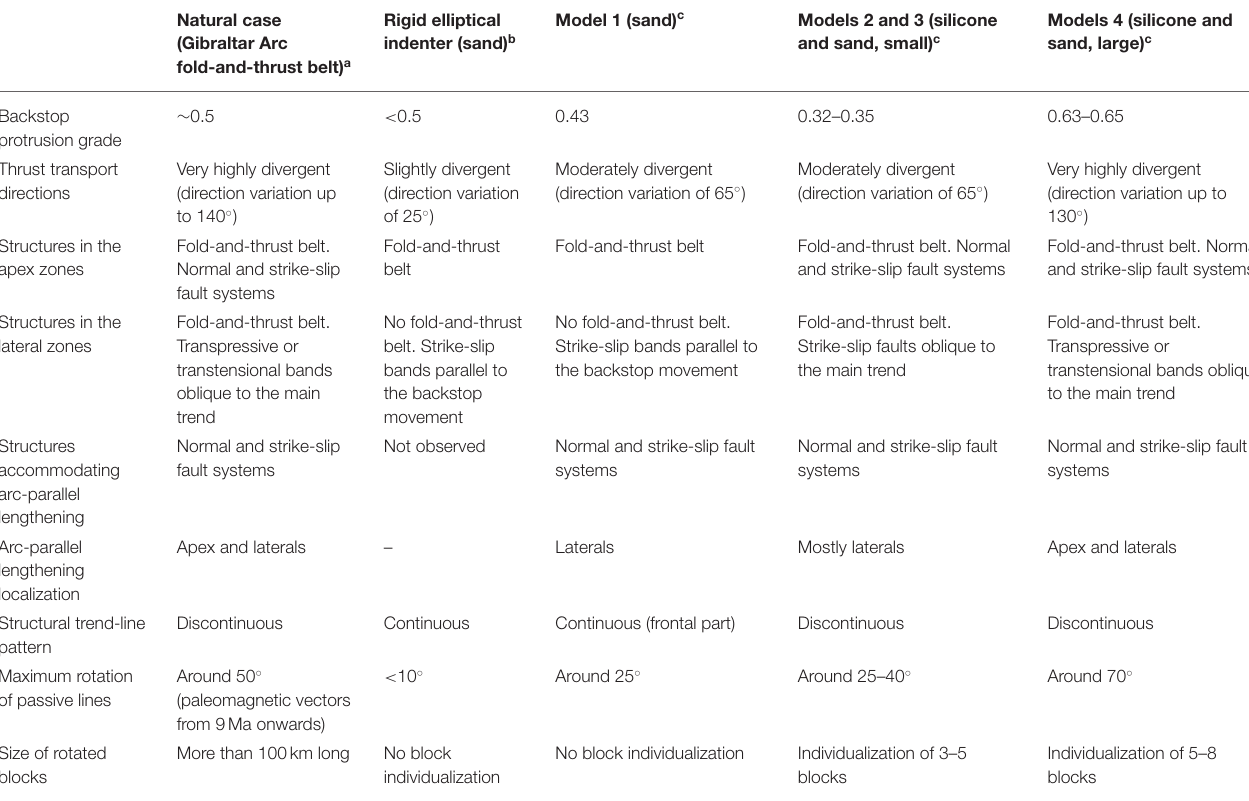
TABLE 3 | Structural characteristics of the external wedge of the Gibraltar Arc system compared with those of our analog